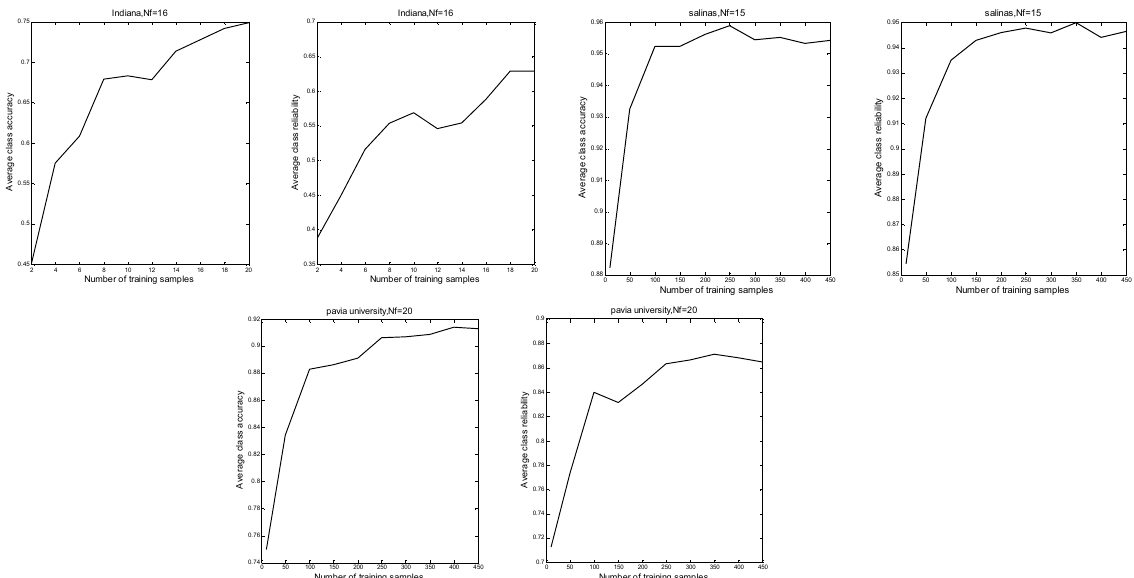
Figure 7. The average class accuracy and average reliability accuracy versus the number of training